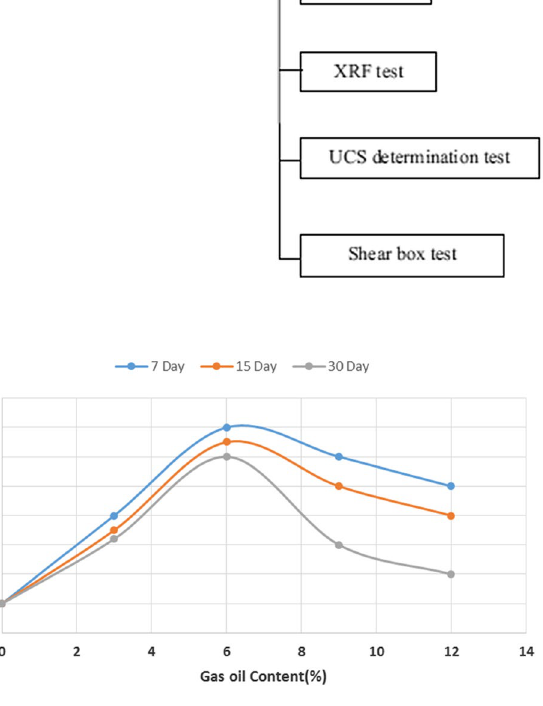
Fig. 7 Liquid limit variation in different curing times and different gasoline contents in fine-grained soil Fig. 8 Plasticity limit variation in different curing times and differ- ent gasoline contents in fine-grained